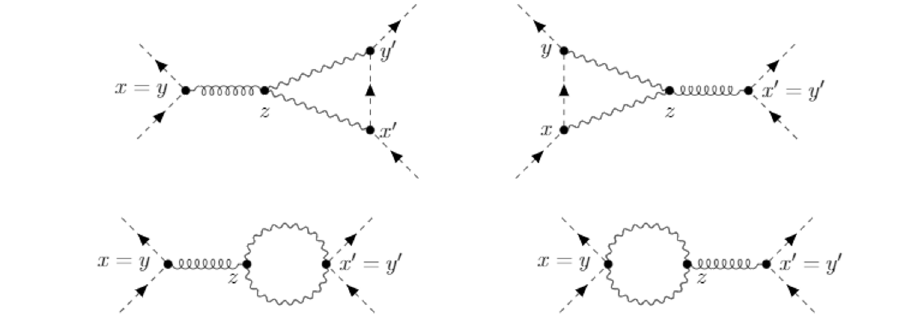
Figure 7 . These diagrams show the contributions from the 1PR (one particle reducible) diagrams corresponding to gravitational vertex corrections. Dashed lines represent massive scalars, wavy lines represent photons and curly lines represent gravitons. These graphs have the same topology as Bjerrum-Bohr’s Diagram 5